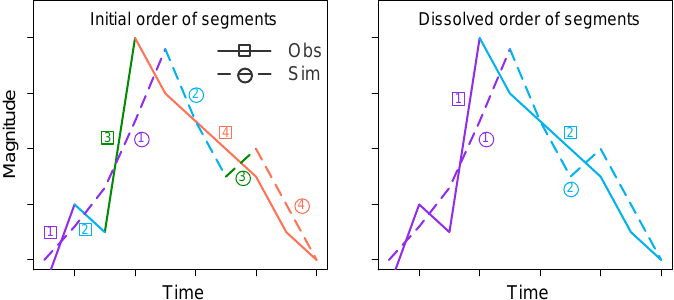
Figure 2. Illustration of the time-ordered matching of segments in the coarse-graining procedure. The rising and falling segments of the simulation (sim) and observation (obs) are numbered and colour-coded according to their chronological order. Series distance compares segments with identical number and/or colour.